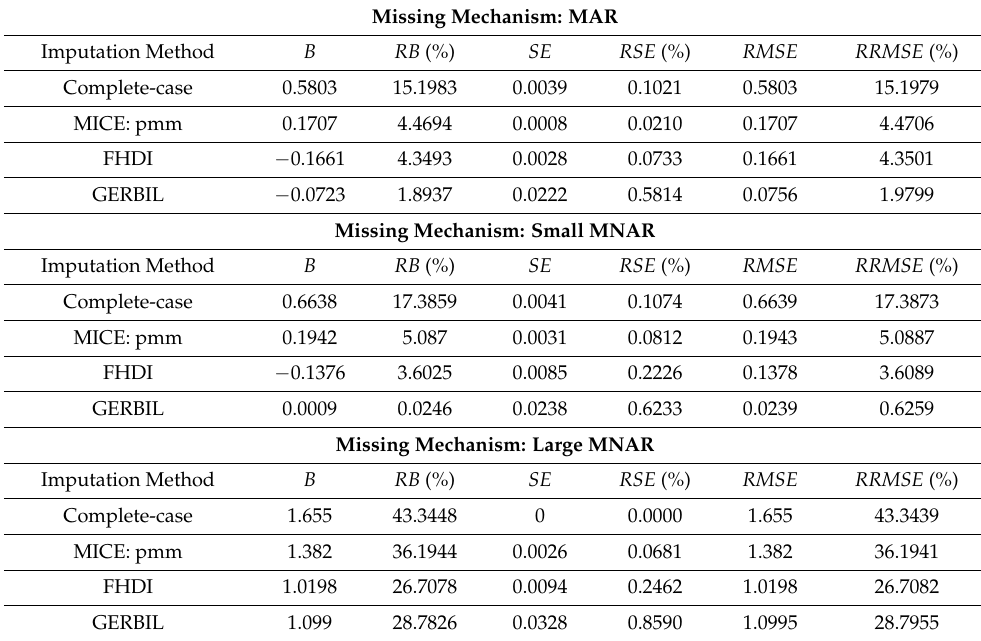
Table 3. Summary of Simulation Results for Mean of NHANES Variable “HsCRP”. Missing Mechanism: